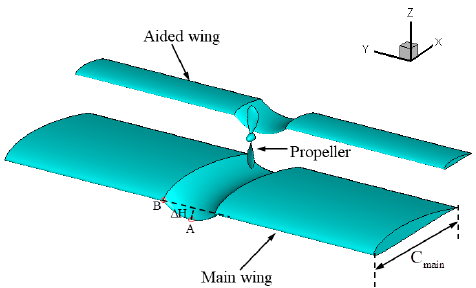
Figure 10. Fuel saving double channel wing configuration.